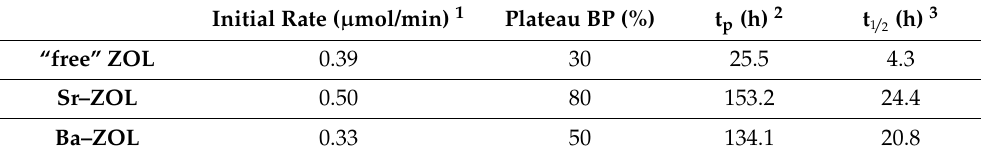
Table 3. Kinetic data for the drug release from tablets with “free” ZOL, Sr–ZOL and Ba–ZOL.